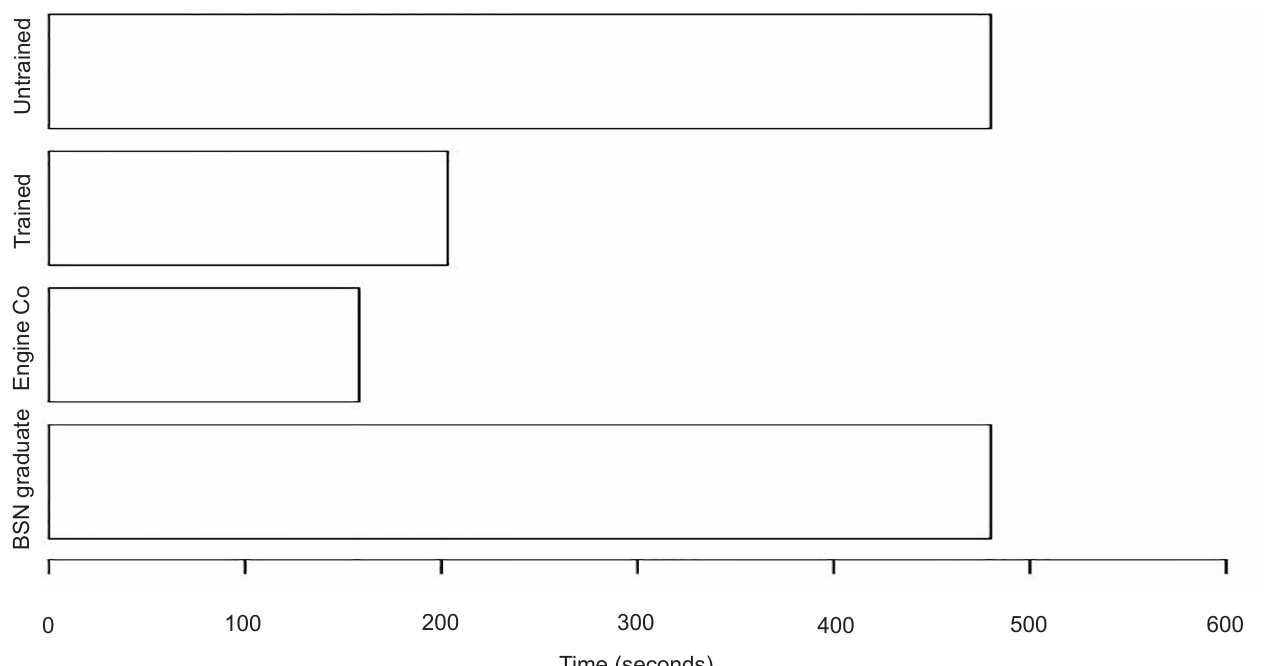
Figure 3. Time to Solution (TtS) of trained vs untrained groups in arterial hemorrhage control scenario, as well as emergency medical services and healthcare (nursing graduates) professionals (p-value = 0.001446, confidence interval [CI], -∞, -204.416). Engine Co, fire department first responders; BSN, Bachelor of Science with a major